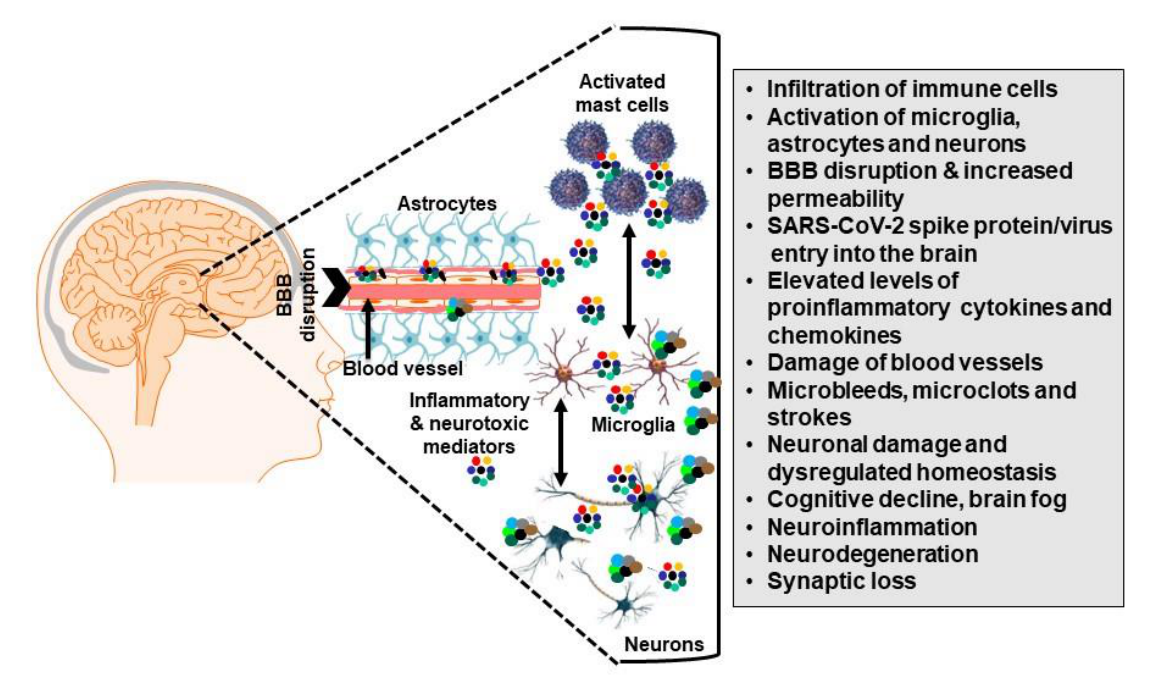
Figure 1. Schematic diagram showing the proposed role of mast cells and microglia in the pathogen- esis of neuro-COVID. A variety of triggers including toxins and viruses such as SARS-CoV-2 can reach the hypothalamus, mostly through the nose and olfactory nerve tract. There, they can disrupt the BBB via activation of perivascular mast cells, which then further increase BBB permeability and activate microglia. Proinflammatory molecules released from microglia can damage neurons, disrupt homeostasis, and contribute to the pathogenesis of neuro-COVID.